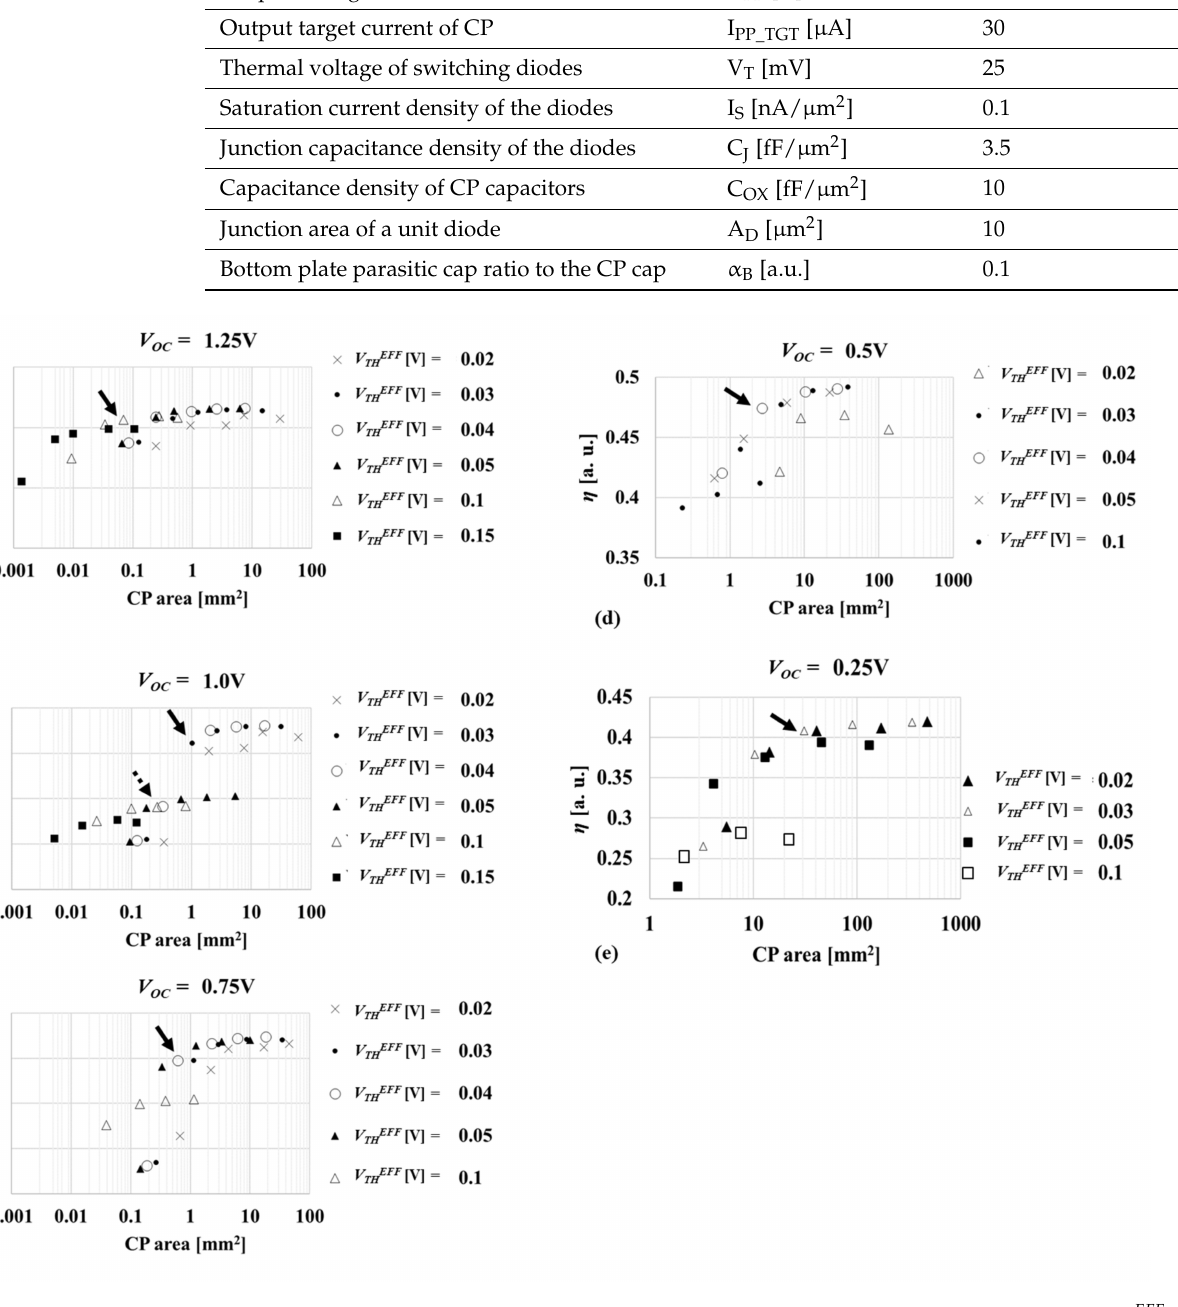
Figure 10. η vs. CP area at V OP at 1.25 V ( a ), 1.0 V ( b ), 0.75 V ( c ), 0.5 V ( d ), and 0.25 V ( e ). V THEFF is varied between 0.02 V and 0.15 V and N D is varied among 10, 30, 100, 300,